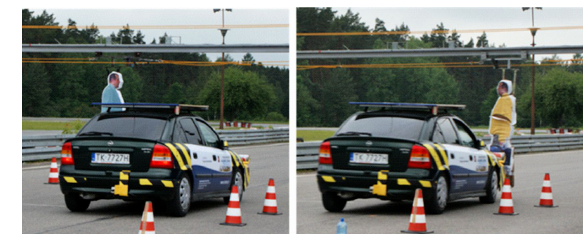
Fig. 3. Diagram of ‘Scenario 2’